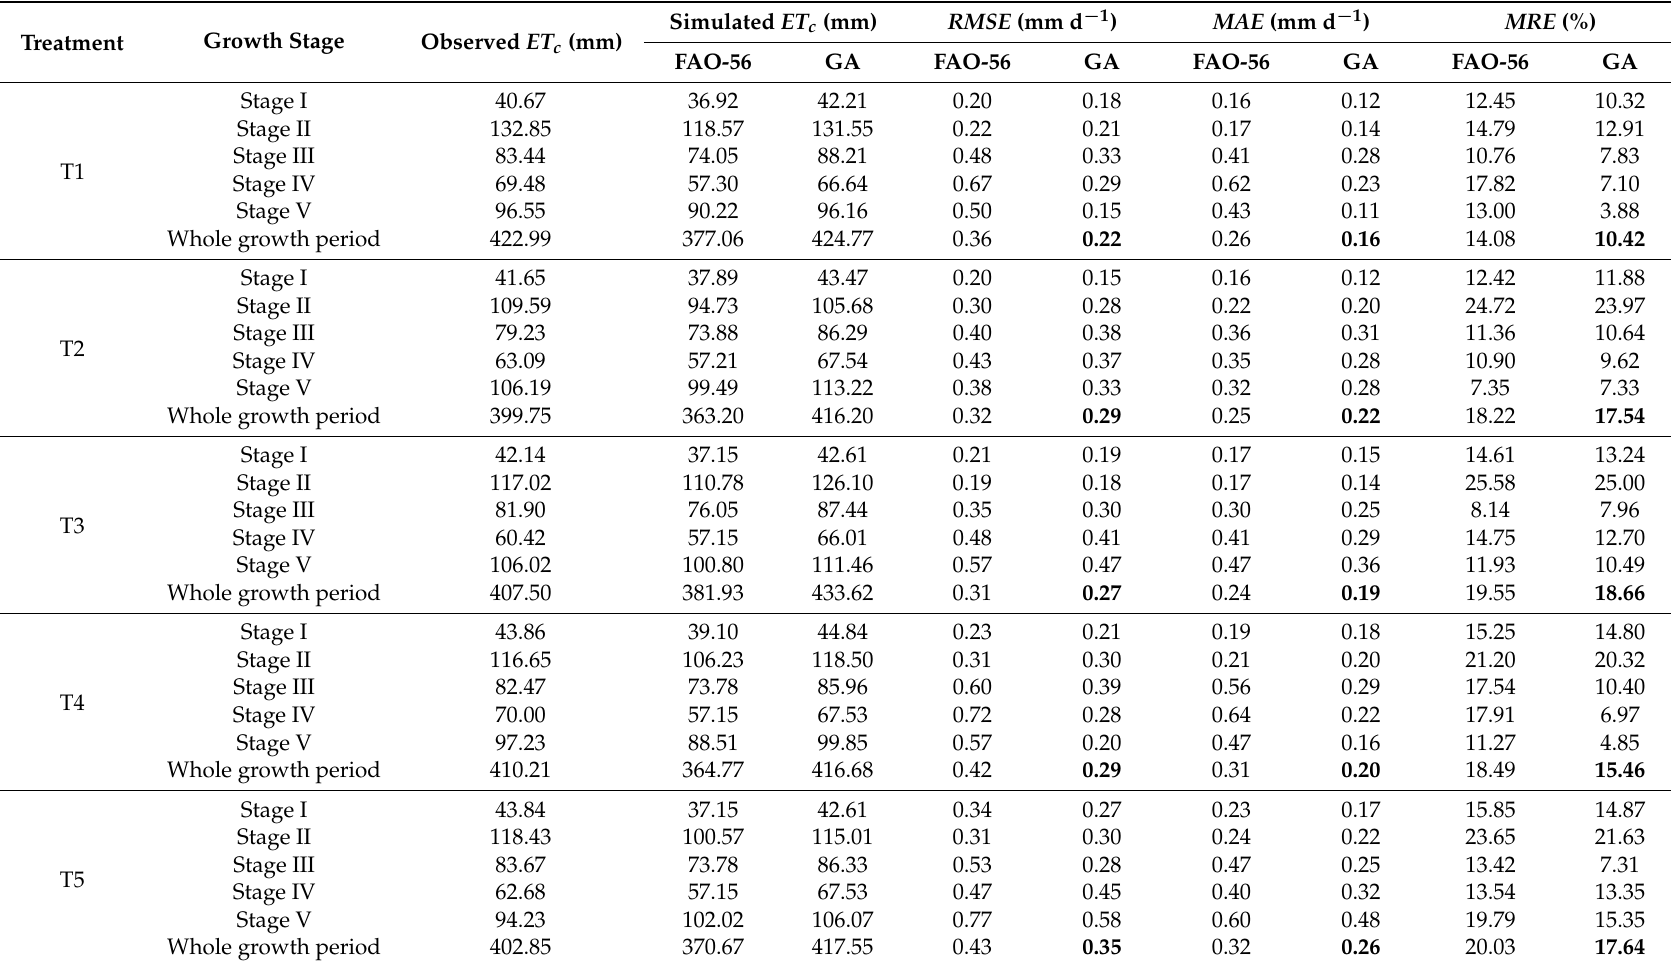
Table 8. Estimated winter wheat evapotranspiration ( ET c ) during each growth stage for different deficit irrigation treatments using the crop coefficients recommended by the FAO-56 and optimized by the genetic algorithm (GA), and the corresponding root mean square error ( RMSE ), mean absolute error (MAE) and mean relative error ( MRE